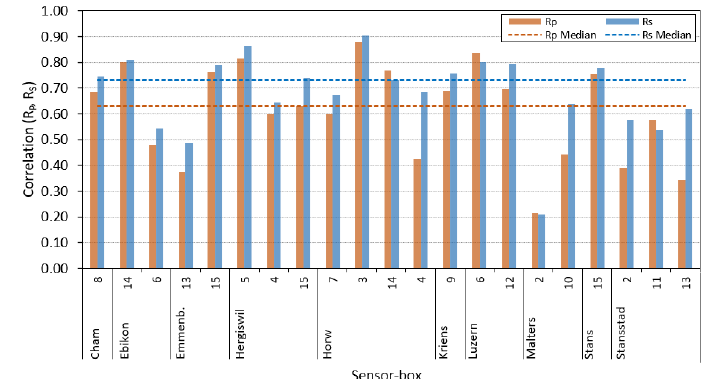
Figure 12. Pearson correlation R P and Spearman correlation R S for mean hourly PM 10 data between sensor-box and in-luft stations compared among different pilot sites. Evaluation of data collected between May and December 2021. Fixed percentile filtering method (99.0%) is applied to the raw sensor-box